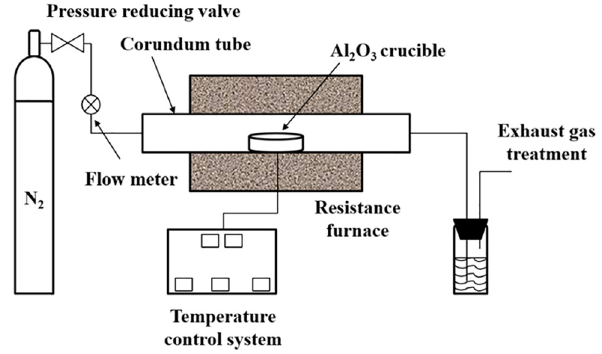
Figure 1: Schematic of coal char preparation